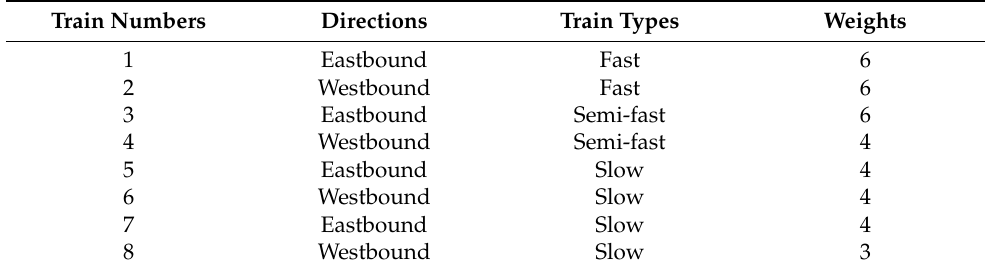
Table 15. Train orders in the 4 + 4 train instance.